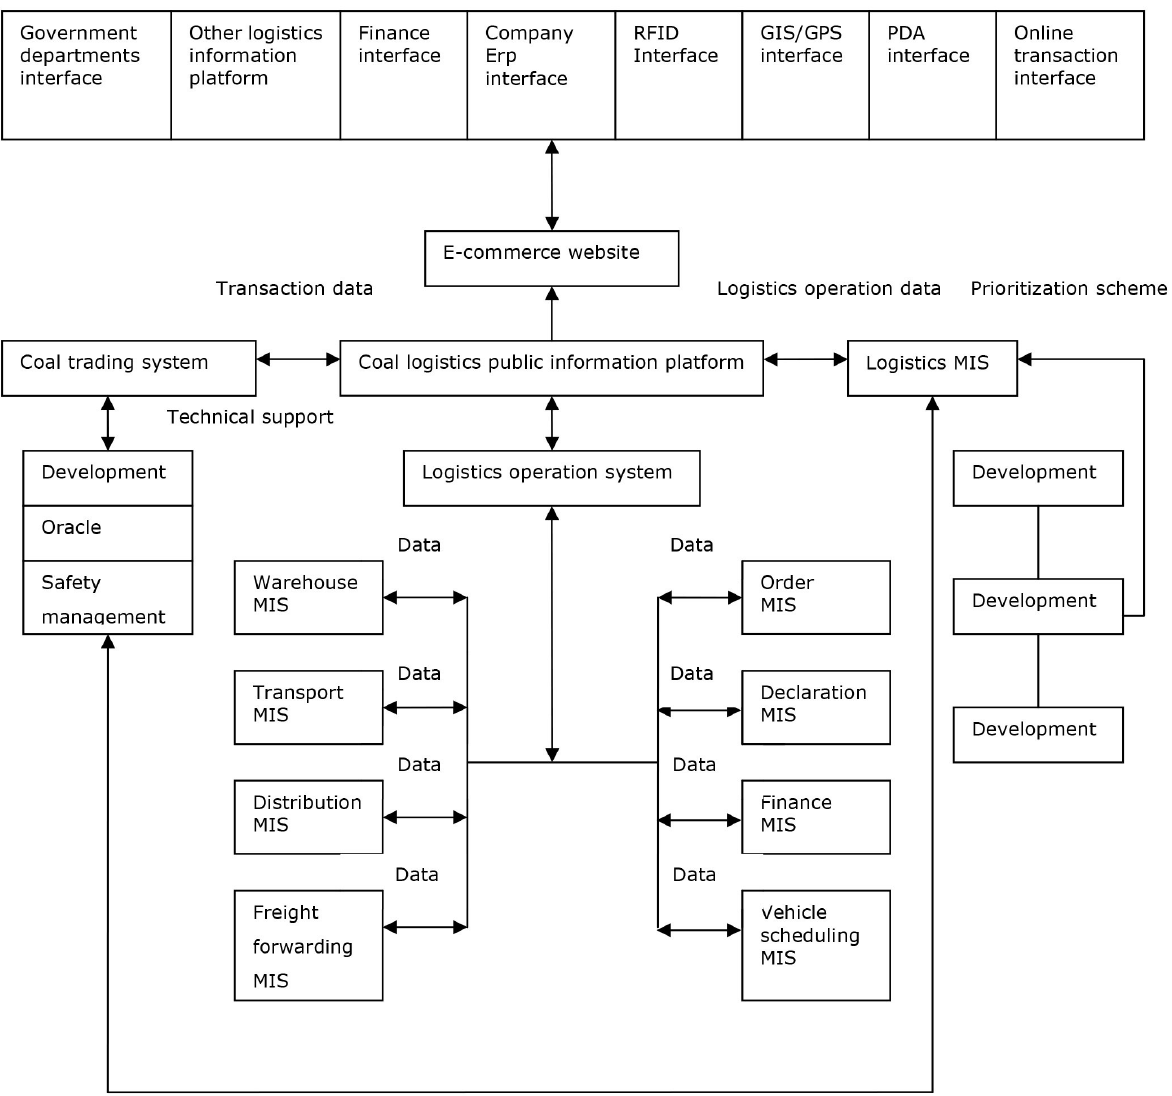
Figure 2. Flow chart of the Public Information Platform for Coal